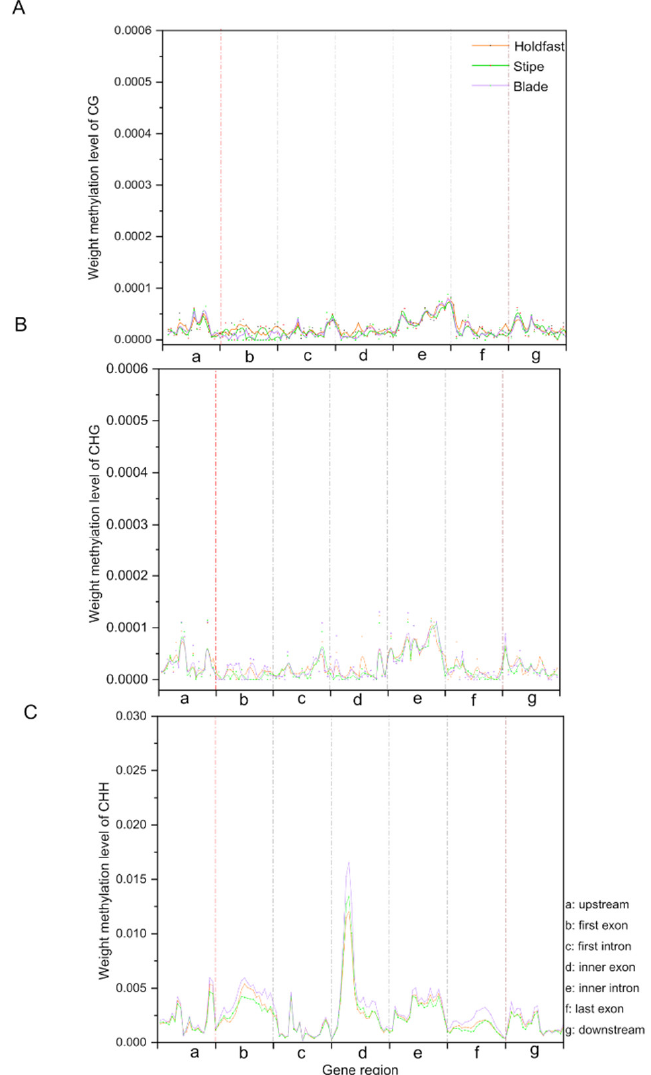
Figure 2. Distribution of DNA methylation levels of CG ( A ), CHG ( B ) and CHH ( C ) context across gene features in holdfast (navajo white), stipe (light green) and blade (medium orchid) of sporophytes. The X axis represents seven genomic features, with a, b, c, d, e, f, and g denoting upstream, first exon, first intron, inner exon, inner intron, last exon, and downstream, respectively. The Y axis indicates the methylation levels of seven gene features.